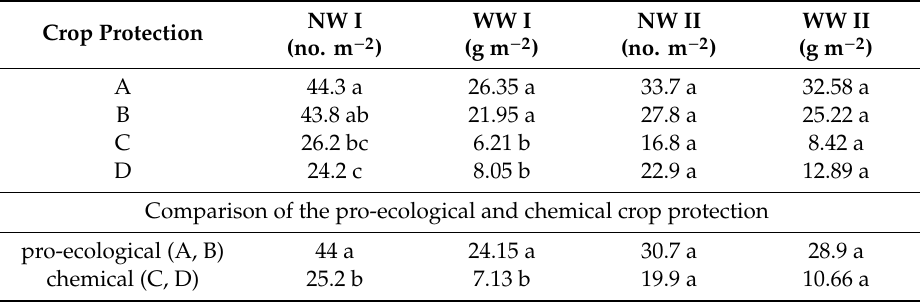
Table 3. The impact of crop protection system on weed infestation indicators in the spelt wheat cv. “Schwabenspelz” (mean for 2013–2015). NW I—number of weeds 3–4 weeks after herbicide treatment, WW I—air-dry weight of weeds 3–4 weeks after herbicide treatment, NW II—number of weeds at the dough stage of spelt wheat (BBCH 83–85), WW II—air-dry weight of weeds at the dough stage of spelt wheat (BBCH 83–85). Different letters denote significant differences (p ≤ 0.05). The same letter means not significantly different values.